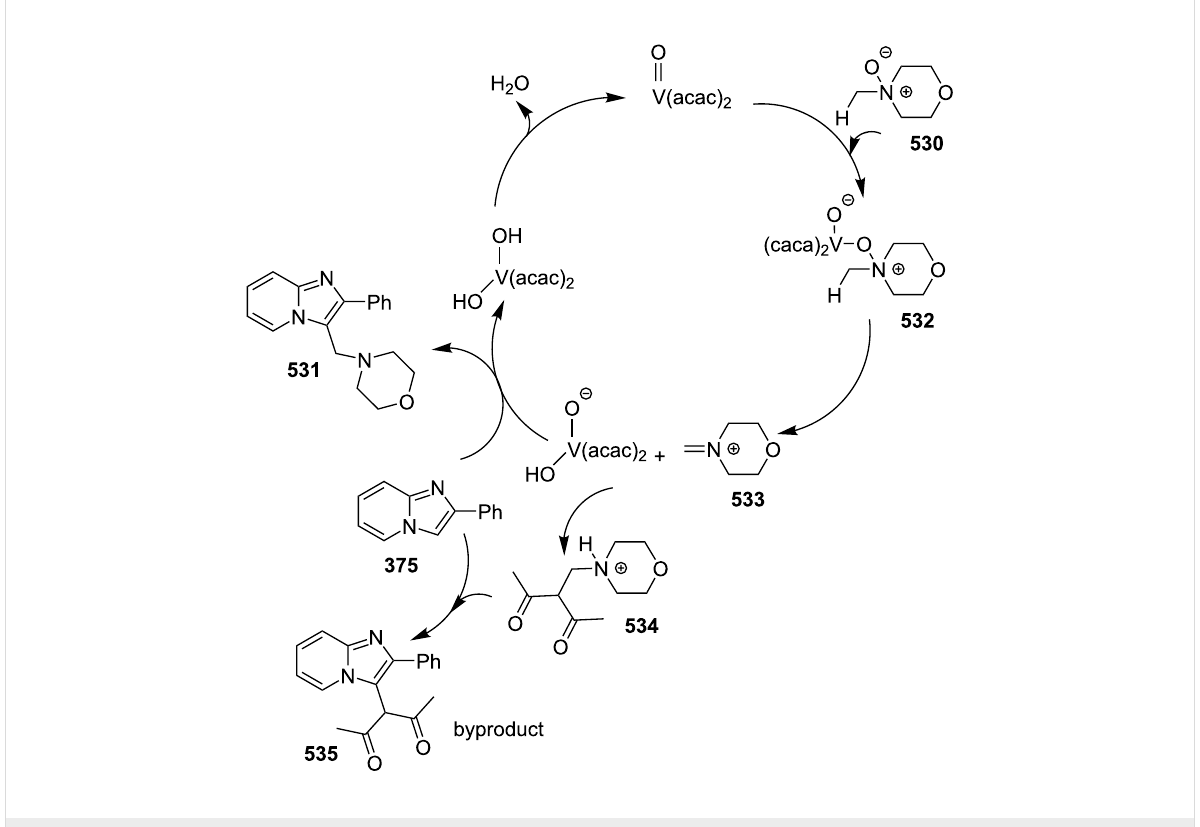
Scheme 188: Mechanistic